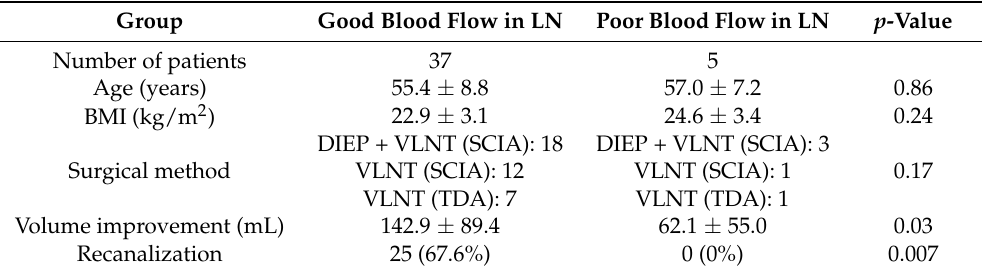
Table 1. Patient characteristics and study results. Recanalization was confirmed by indocyanine green fluorescent lymphography. Group Good Blood Flow in LN Poor Blood Flow in LN p -Value Number of